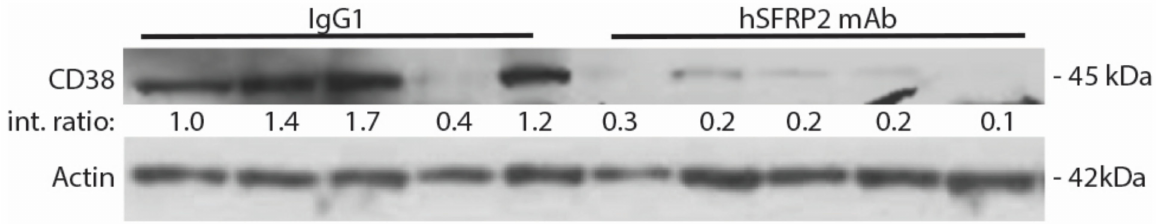
Figure 5. Treatment with hSFRP2 mAb in mice with metastatic osteosarcoma decreases CD38 protein levels in splenocytes. Splenocytes isolated from mice with RF577 OS lung metastases treated with IgG1 control ( n = 5) versus hSFRP2 mAb ( n = 5) were lysed and prepared for Western blot analysis probing for CD38. Int. ratio: intensity ratios listed below CD38 Western blot were calculated after normalization to both actin and the reference sample (indicated by 1.00). Overall, CD38 protein levels were reduced in splenocytes from mice treated with hSFRP2 mAb by 82%, compared to the control group ( p =